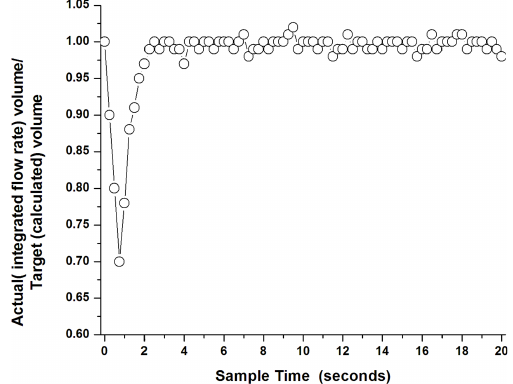
Fig. 2. Effect of pressure spikes upon opening the ISR sample valves on the ratio of actual flow rate/target flow rate. To eliminate these pressure spikes, values of w corresponding to sample times > 3.0s were not sampled. This conservative estimate resulted in the inclusion of a dead-band threshold in the DEA measurements, but such a threshold has negligible effect on sample volumes accumu- lated or calculated flux (see text for